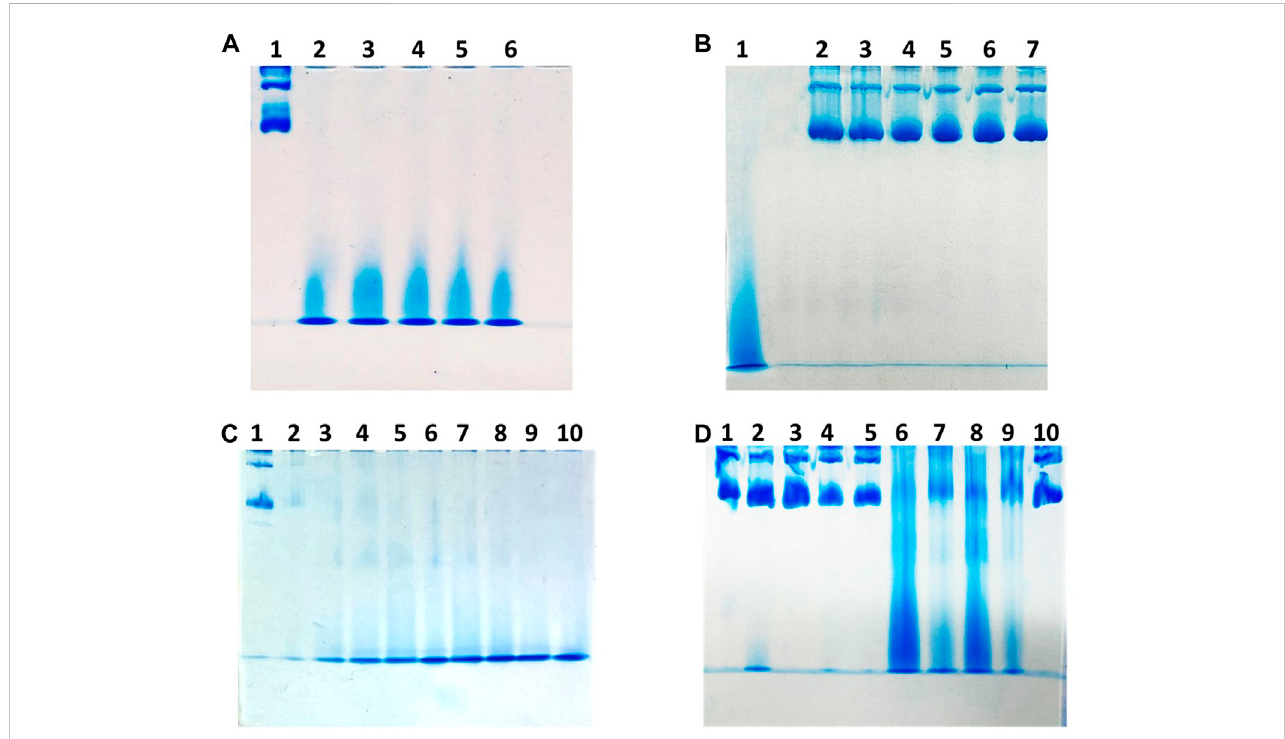
FIGURE 1 GelelectrophoresisundernativeconditionsofhHFttoevaluate theassemblystate upondifferenttreatments. Panel(A) lane1 untreatedhHFt; from lane 2 to lane 6 hHFt incubated with 1.0%, 1.5%, 2.0%, 2.5% and 3.0% SDS, respectively. Panel (B) lane 1 untreated hHFt; from lane 2 to lane 6 hHFt incubated with 1.0%,1.5%,2.0%, 2.5%and3.0%SDSafterSDSremovalbydialysisagainst20 mMTris-HCl pH7.4. Panel(C) lane1 untreatedhHFt; from lane2 to lane10 hHFt incubatedwith0.01%,0.02%,0.03%,0.04%,0.05%,0.06%,0.07%,0.08%,and0.09%SDS,respectively. Panel(D) lane1 :untreatedhHFt; lane2 hHFt pH12 ; lane 3 hHFt lane 4 hHFt lanes 5 hHFt lanes 6 hHFt lane 7 hHFt lane pH 12- > 7.4 (reassembled); pH 13 ; pH 13- > 7.4 (reassembled); pH 1.5 ; pH 1.5- > 7.4 (reassembled);